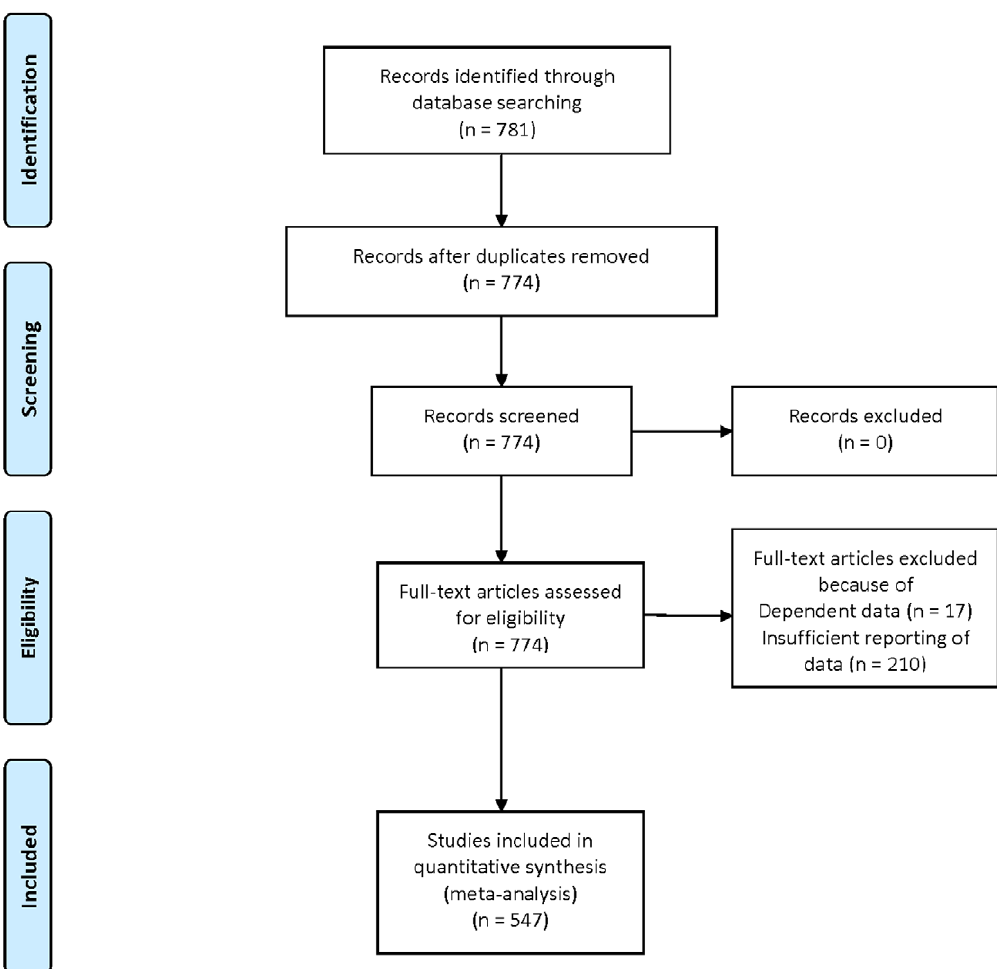
Figure 1. Flowchart illustrating study inclusion and exclusion.